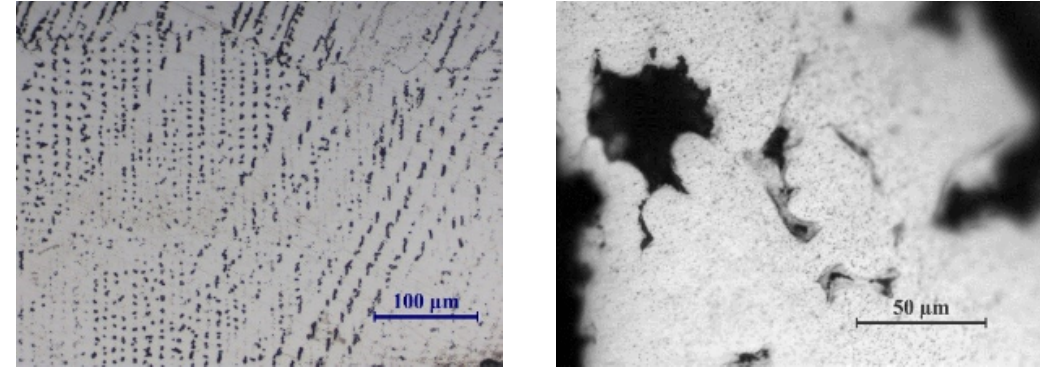
Figure 5. Microstructure of Co-Cr alloy